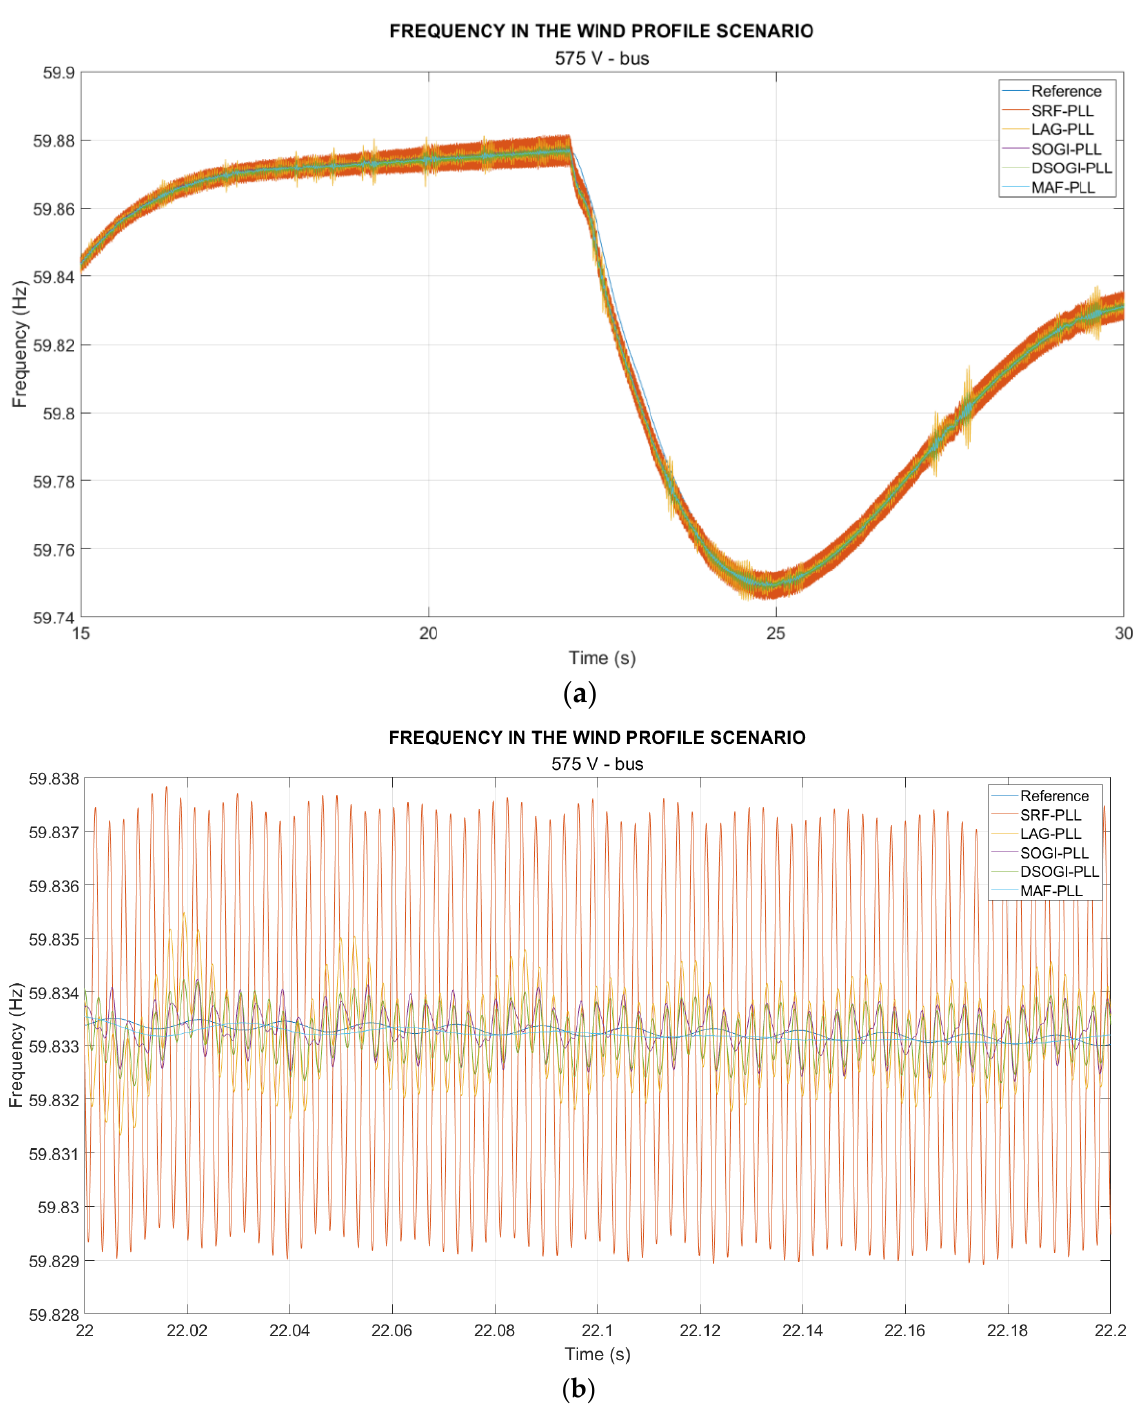
Figure 16. Frequency measurement with the PLLs located at the 575 V bus: ( a ) PLLs measuring from seconds 15 to 35, and ( b ) detail of the measurements from seconds 22 to 22.2.